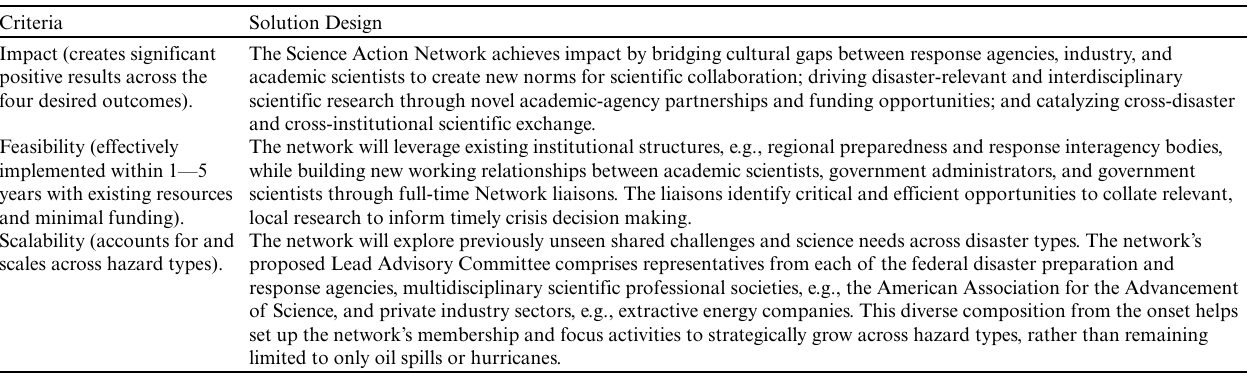
Table 4 . The criteria used to evaluate the project ideas and how the final proposed solution met those criteria. Criteria Solution